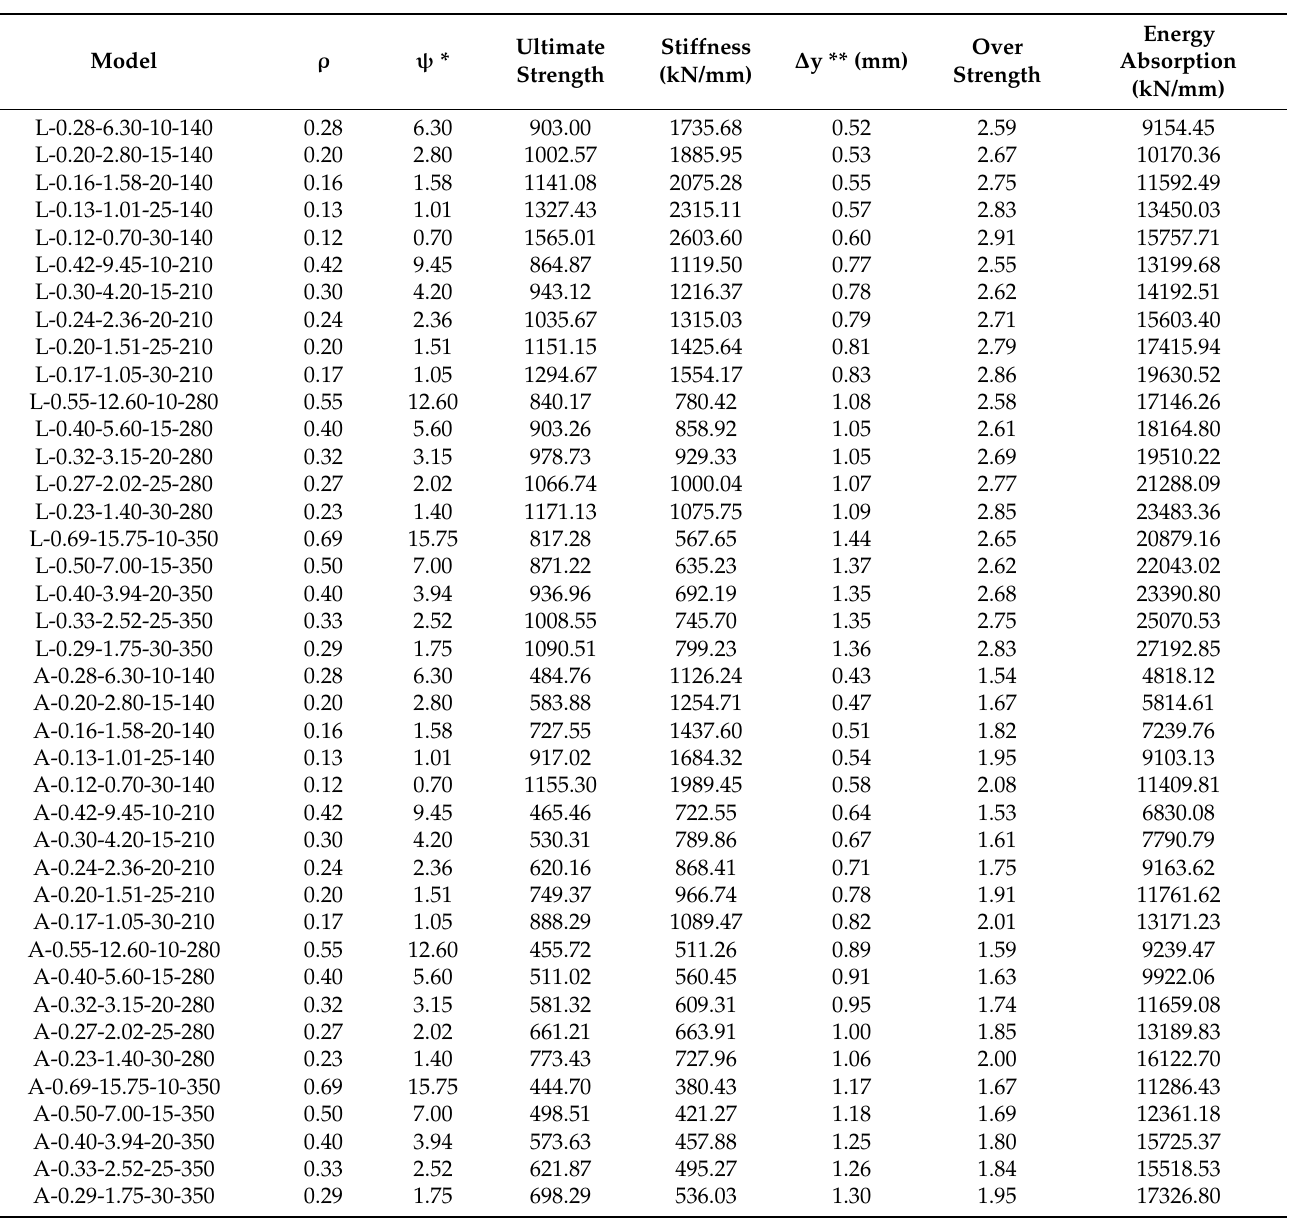
Table 3. The structural